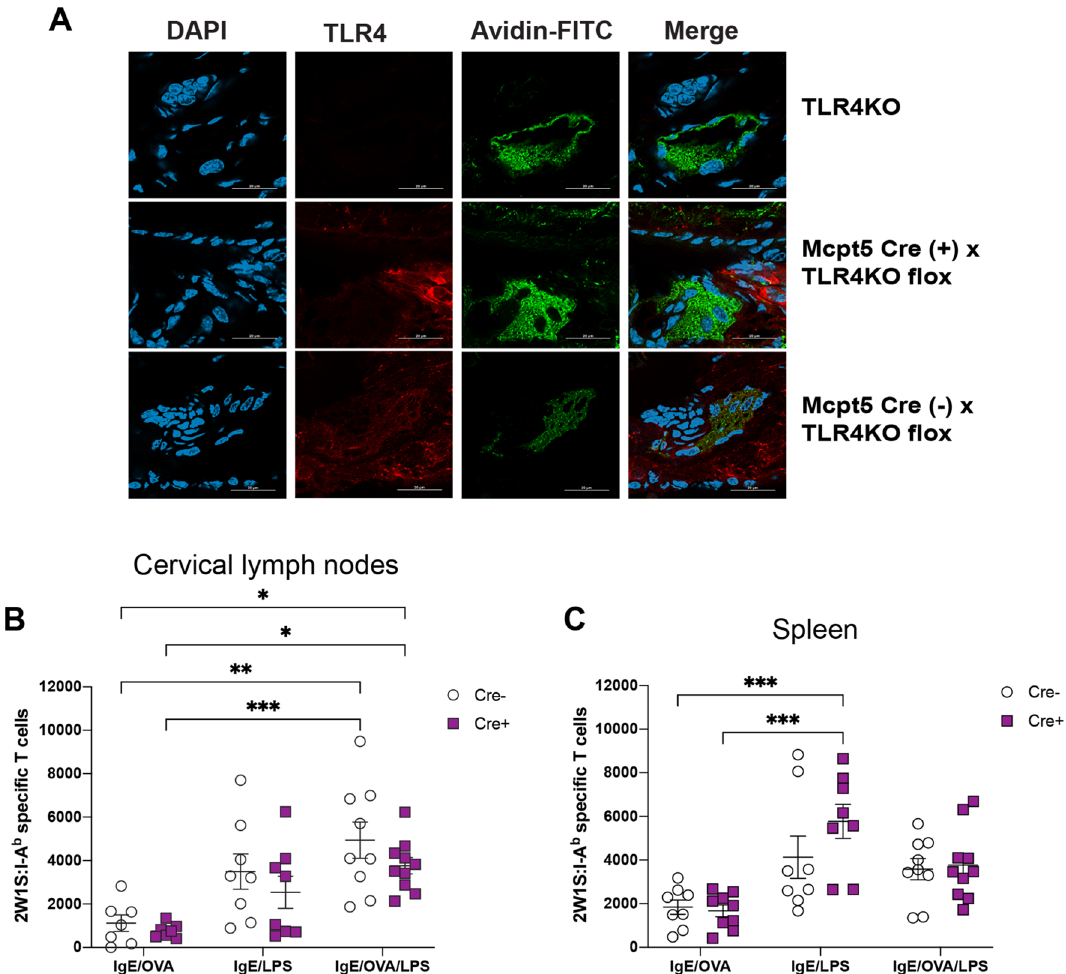
Figure 5. TLR4 expression on mast cells is not entirely responsible for the IgE/OVA- and LPS-mediated expansion of antigen-specific CD4 + T cells. ( A ) Tissue ear sections from TLR4-deficient mice (top), Mcpt5 Cre ( −) x Tlr4KO flox (middle), and Mcpt Cre ( +) x Tlr4KO flox (bottom) were imaged using confocal microscopy (see “Materials and methods” section). Red (PE) indicates TLR4 stain, green (FITC) indicates MC-granule- specific avidin stain, and DAPI (blue) indicates cell nuclei. Image shows that Cre ( +) MCs lack TLR4 expression in comparison to Cre ( −) MCs. ( B , C ) Mast cell-specific TLR4-deficient mice (Cre +) and littermate controls (Cre −) were immunized intradermally in the ears with 2W1S peptide and the indicated combination of IgE, OVA, and LPS. Cervical draining lymph nodes ( B ) and spleens ( C ) were analyzed 10 days later for the numbers of 2W1S-specific CD4 + T cells. Results are cumulative data from 3 independent experiments with n = 7–10 mice total and shown as mean ± SEM. Scale bar, 25 µm. * P < 0.05 ** P < 0.01, *** P < 0.001, **** P < 0.0001. Statistical analysis was performed using one-way ANOVA with Tukey’s multiple comparisons